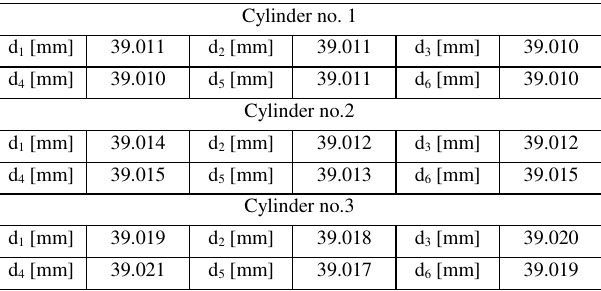
Table 3. Results of cylinder diameter measurement (arithmetic mean)